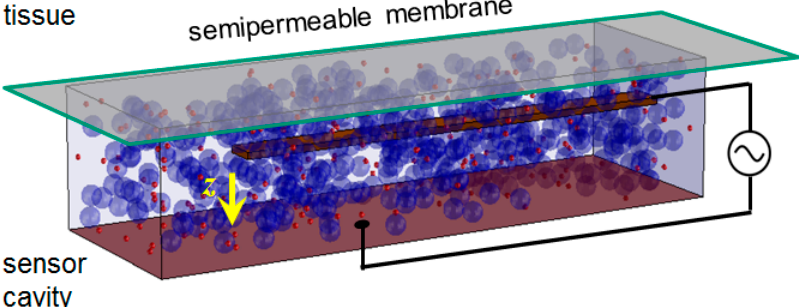
Figure 1. Scheme of affinity sensor microelectromechanical system (MEMS) with reversible binding receptors (small red spheres) and polymers of the analyte (large blue spheres). Analyte molecules (not shown) can pass freely through the semipermeable membrane between tissue and sensor cavity, where they modulate the bonding pattern within the macromolecular network. The state of viscosity is determined by the movement of a bendable beam that is electrically attracted to the ground plate (yellow arrow).